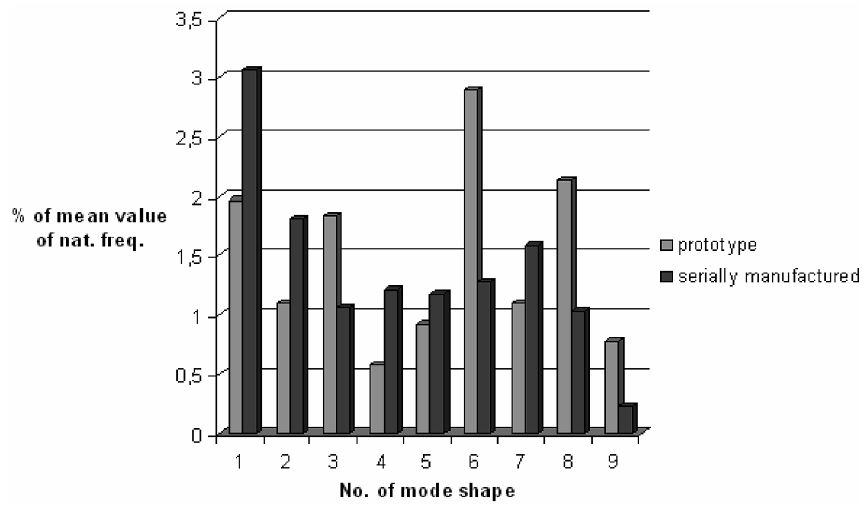
Fig. 13. Comparison of maximum deviation of natural frequencies from the mean value for serially manufactured calipers and deviation of natural frequencies of the prototype caliper from that same mean